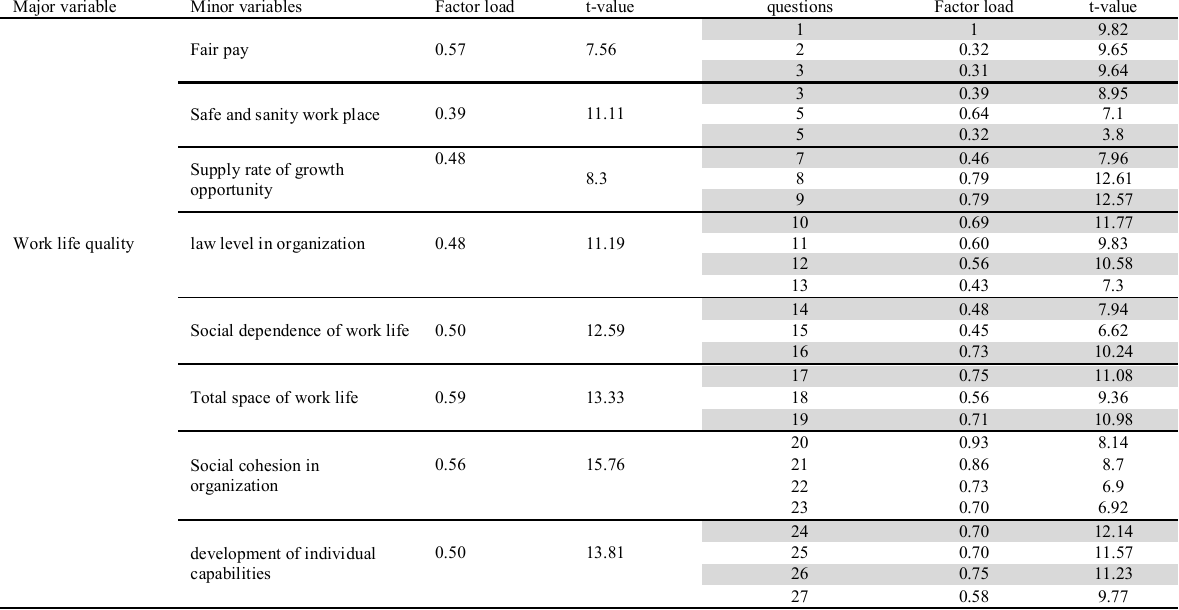
The standard factor load, meaningful statistics (t-value) scale of work life quality Major variable